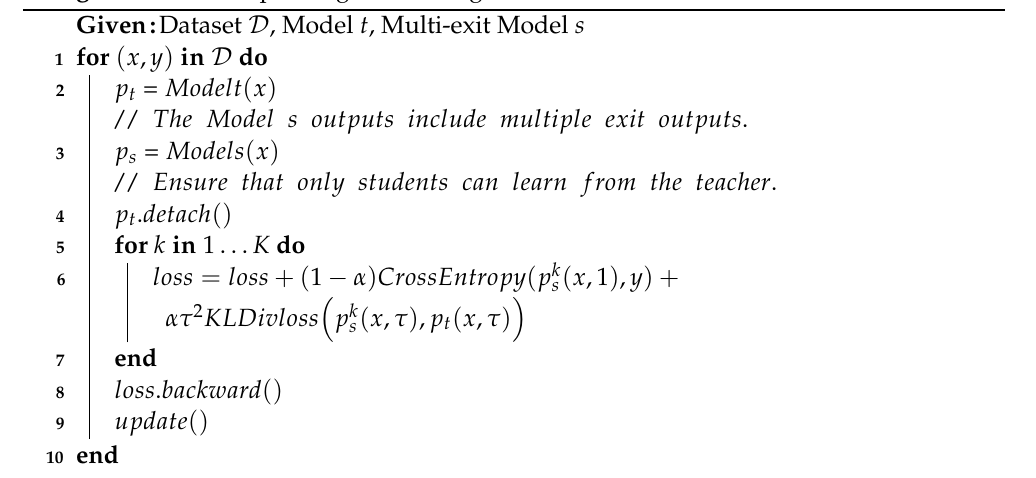
Algorithm 1: Multiple-Stage Knowledge